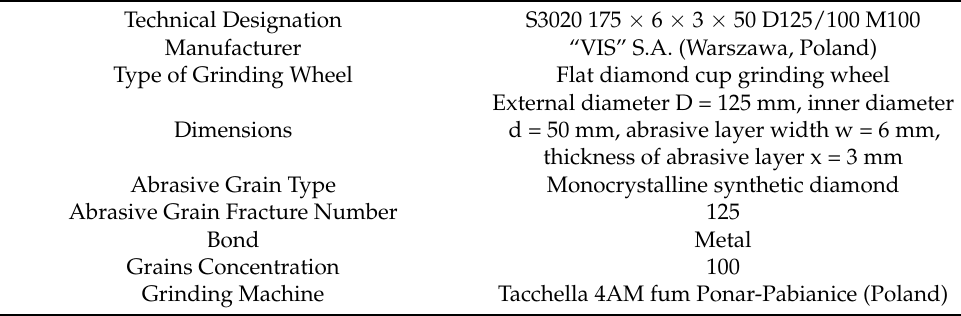
Table 1. Characteristics of the grinding wheels used in the investigations.